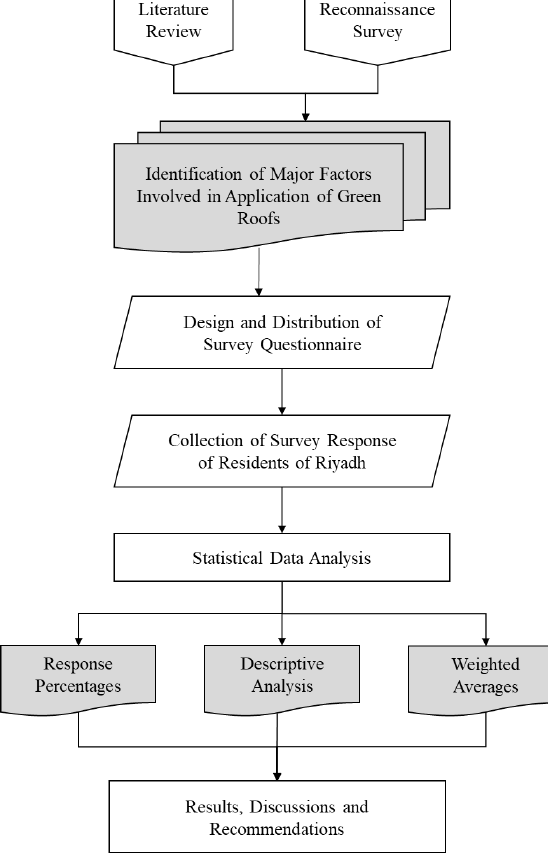
Figure 4. Research methodology followed for the